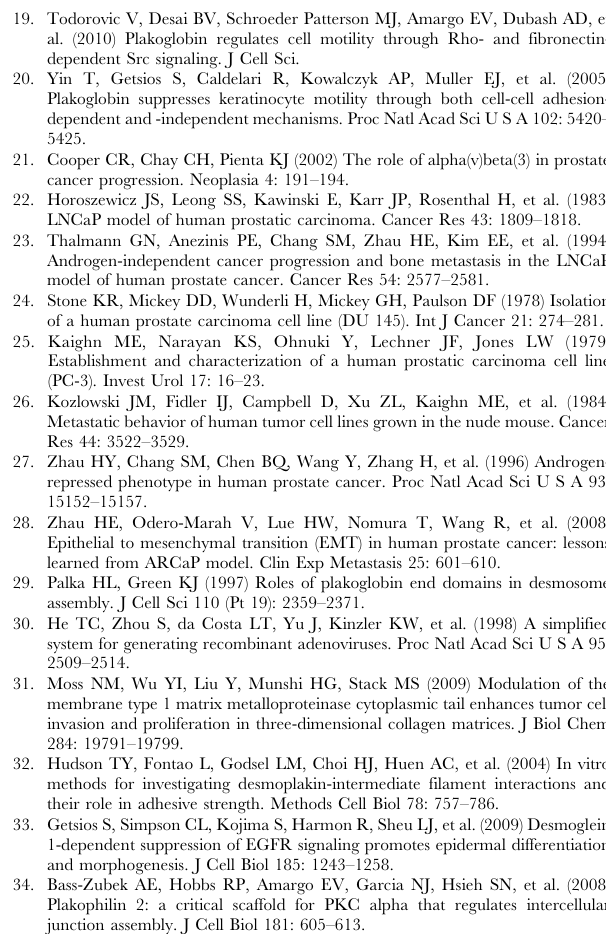
Figure S2 Specific siRNA sequences used to ablate PG from PCa cell lines. A. Western blot demonstrating the efficiency of 4 different individual siRNA sequences, as well as their mix, targeting PG in PC3-M cells. 20 nM final concentration of siRNA was used. B. Representative image of a dispase assay in PC3-M cells after transfection with the sequences shown in panel A. Representative of at least three independent immunoblots are shown, with numbers representing GAPDH normalized PG protein levels for the blot shown. The average level and standard deviation of PG protein levels in panel A is as follows: 0.4 + / 2 0.04,